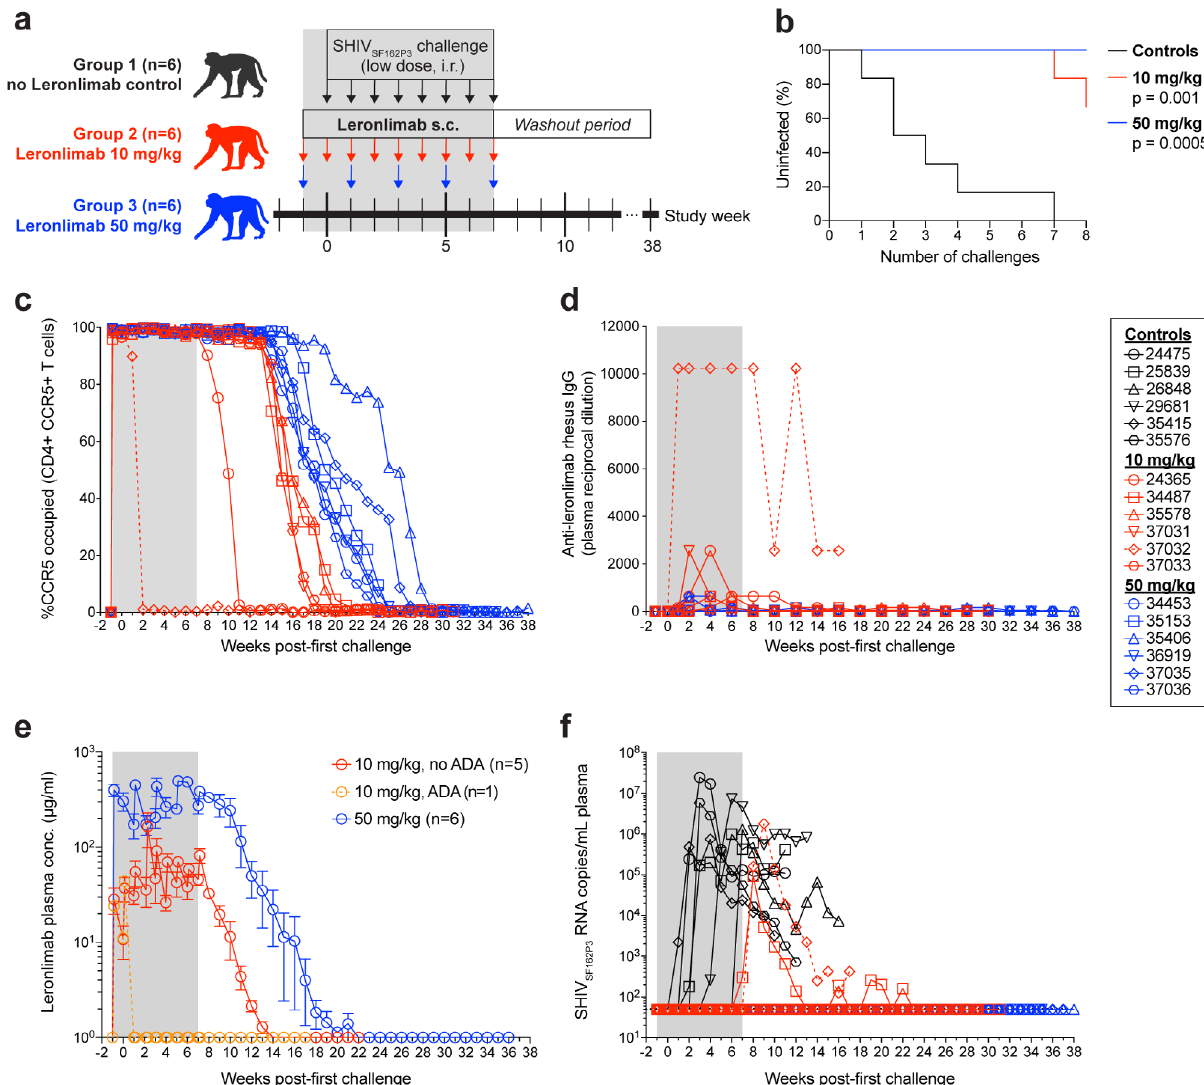
Fig. 2 Leronlimab pre-exposure prophylaxis protects rhesus macaques from intrarectal SHIVSF162P3 acquisition. a Study outline. Eighteen rhesus macaques were challenged with 3.2 TCID 50 of SHIV SF162P3 weekly via intrarectal inoculation for 8 consecutive weeks. Group 1 received no Leronlimab (black, n = 6) while Group 2 received weekly 10 mg/kg Leronlimab (red, n = 6) and Group 3 received biweekly or once-every-two-weeks Leronlimab (blue, n = 6). b Kaplan – Meier curve comparing the percentage of uninfected to the number of SHIV ’ s SF162P3 challenges, analyzed by log-rank test with Dunn correction. c Longitudinal CCR5 receptor occupancy levels on peripheral blood CCR5 + CD4 + T cells in Leronlimab-treated macaques as determined by fl antibodies; orange). f Longitudinal SHIV SF162P3 plasma viral loads. Horizontal dashed line denotes assay limit of quanti fi cation (50 copies/mL); gray boxes in a , c – f denote the Leronlimab treatment phase for Leronlimab-treated macaques. Legend at right shows symbols used in panels c , d , f identifying individual rhesus macaques. The macaque that developed persistent anti-Leronlimab rhesus IgG antibody levels (37032) is shown as a dashed line throughout panels c – f . Group colors and individual animal symbols are consistent throughout the manuscript. Source data are provided as a Source Data fi